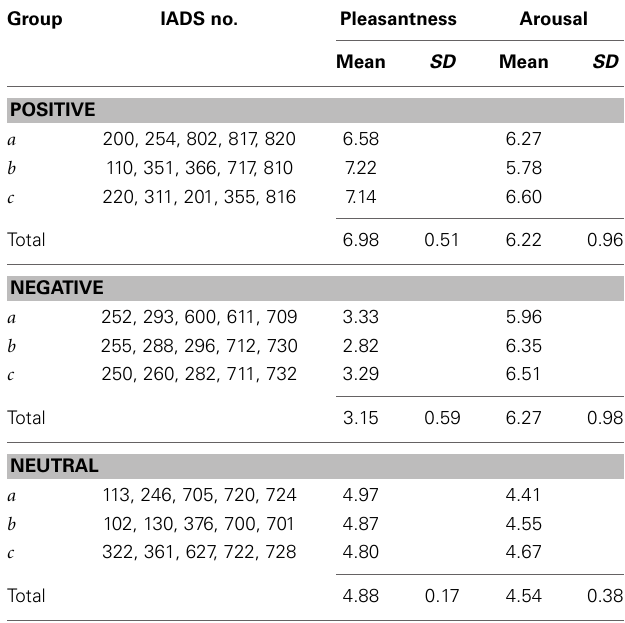
Table 1 | Acoustic stimuli used in the study and their average ratings.